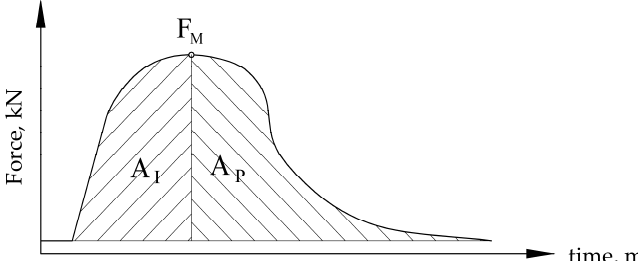
Figure 3. Separation of energies for crack initiation and propagation.